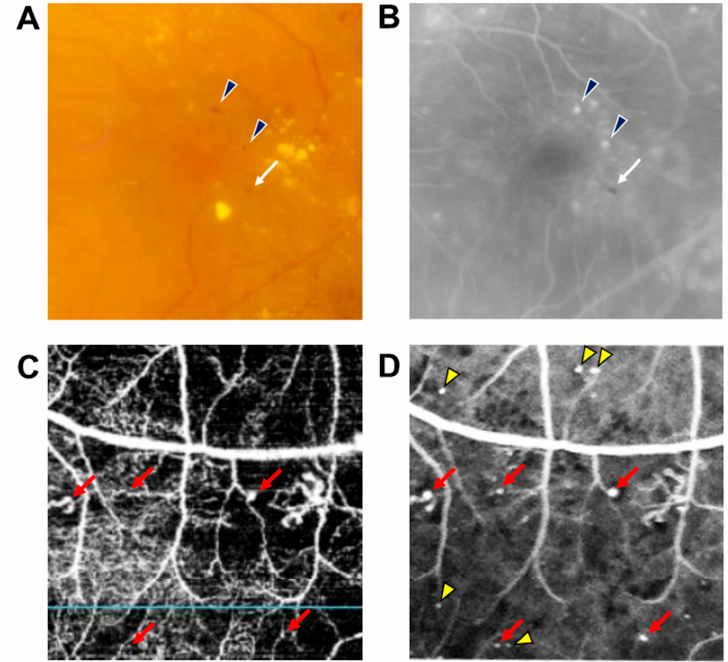
Figure 1. Microaneurysms detected by fluorescein angiography and optical coherence tomography angiography (OCTA). ( A ) Both microaneurysms (MAs) and dot hemorrhages are shown as red dots on fundus photographs. ( B ) MAs are depicted as hyperfluorescent (black arrowheads), and dot hemorrhages as hypofluorescent (white arrows) on fluorescein angiography (FA). In the detection of MAs by OCTA ( C ), some MAs depicted by FA ( D ) are detected (red arrows), while others are not (yellow